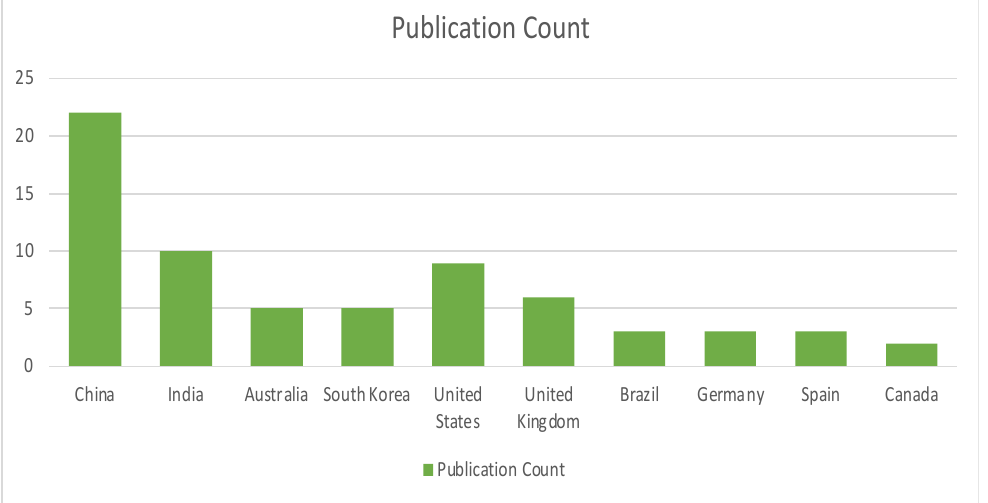
Figure 15. Region-specific publication distribution for Blockchain-as-a-Service.